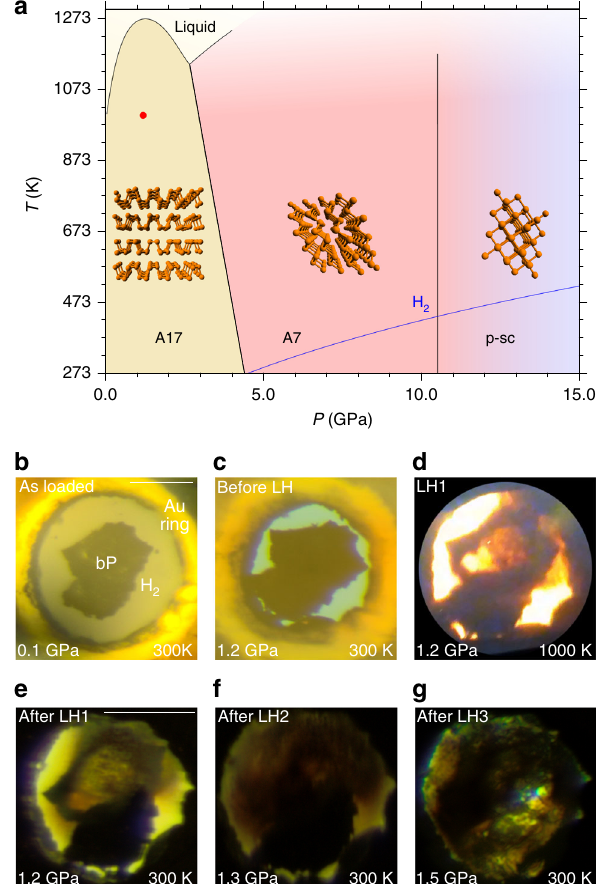
Fig. 1 Phase diagram and reactivity of P and H 2 at high pressure and high temperature. a Phase diagram of phosphorus (black lines), showing the stability regions of the orthorhombic (A17, P black ), rhombohedral (A7) and pseudo simple-cubic (p-sc) structures 4,5 . The melting line of H 2 73 (blue line) and laser heating conditions (red point at P = 1.2 GPa, T ≈ 1000K) are also displayed. b – g Microphotographs showing the sample aspect after loading ( b ), before, during and after LH1 ( c – e ), after LH2 ( f ), and after LH3 ( g ) at pressure ranging between 1.2 and 1.5 GPa (LH1, LH2, and LH3, respectively, indicate the fi rst, the second and the third laser heating). The scale bars in the top right corner of b , e correspond to 100 μ